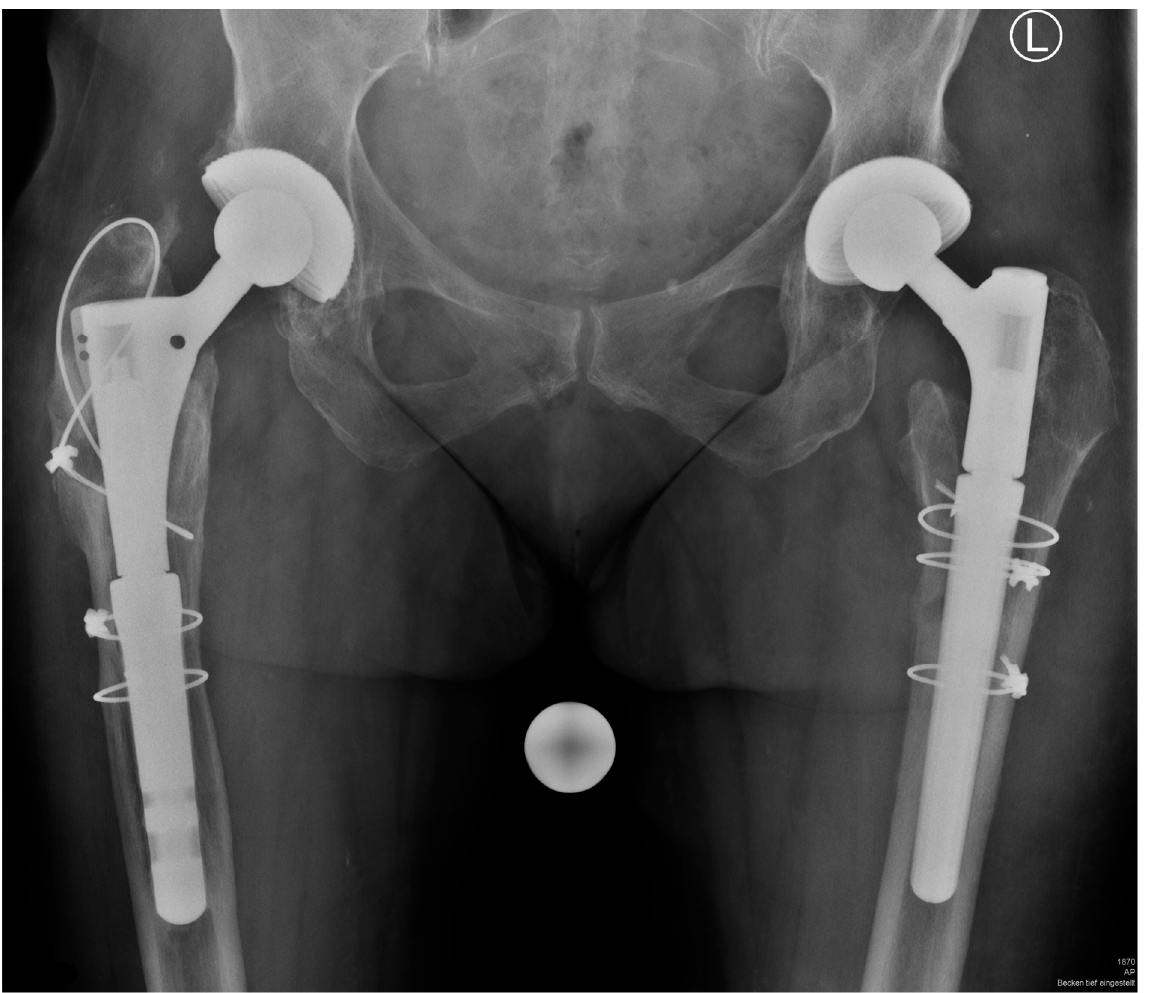
Figure 7. Patient T. R. after 4 years postoperatively by transfemoral approach. Revision was performed by another modular tapered revision device. A shorter system with another tapered modular revision system was used for the type 2 defect. The junction area is more distal with a supportive bone situation at the neck proximal to the junction. Meanwhile, a periprosthetic fracture occurred on the left side with identic therapy in a type 2 defect (1 year postoperatively).